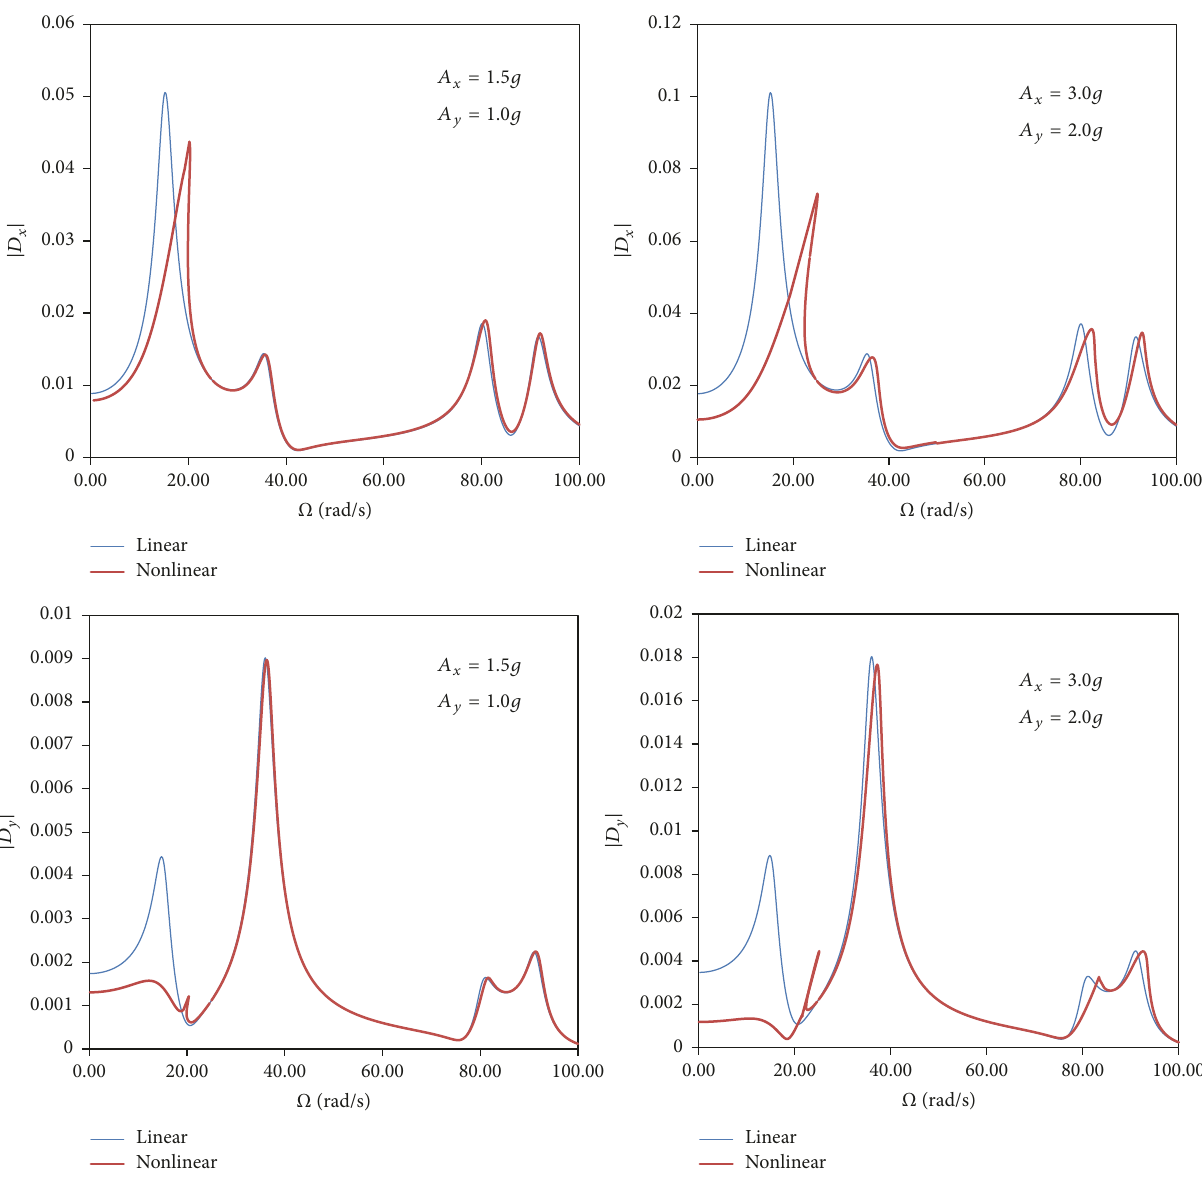
Figure 16: Horizontal and vertical displacements at top of the frame as a function of the forcing frequency due to simultaneous horizontal and vertical forcing. 𝐿 = 10 m and 𝐻 = 6